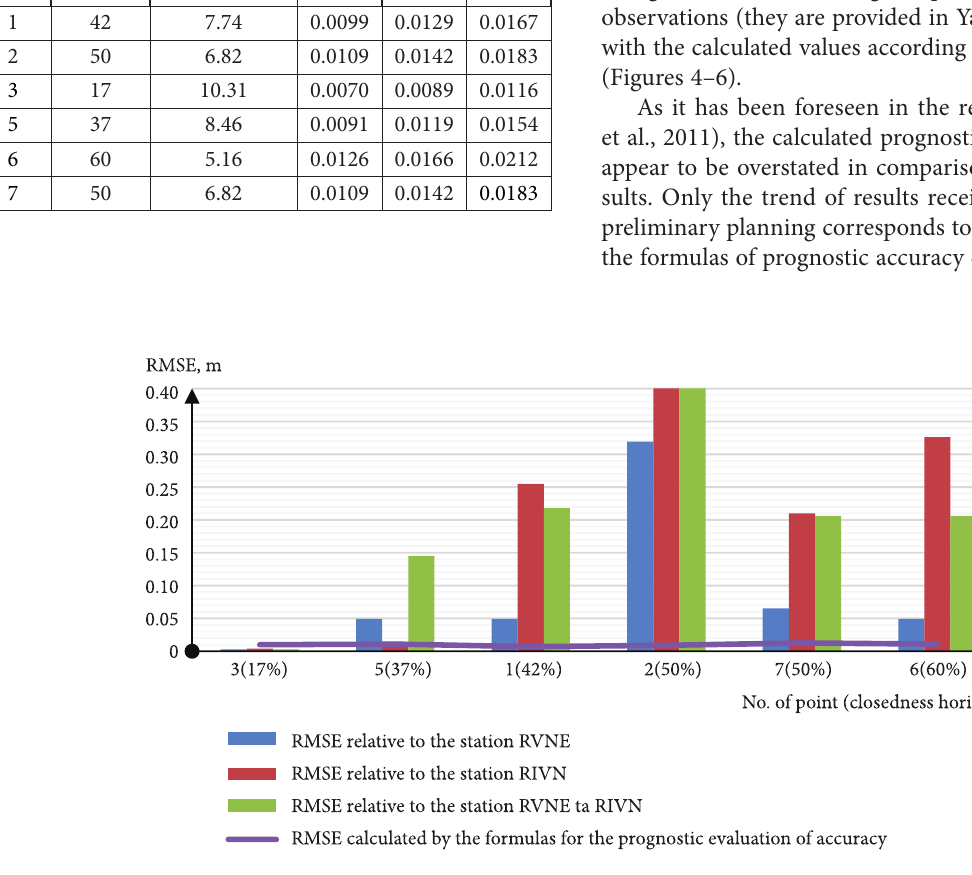
Figure 1. Comparison of RMSE of the planned location by the session duration for 1 hour without executing the preliminary planning and prognostic points of accuracy evaluation calculated by Equation (5)